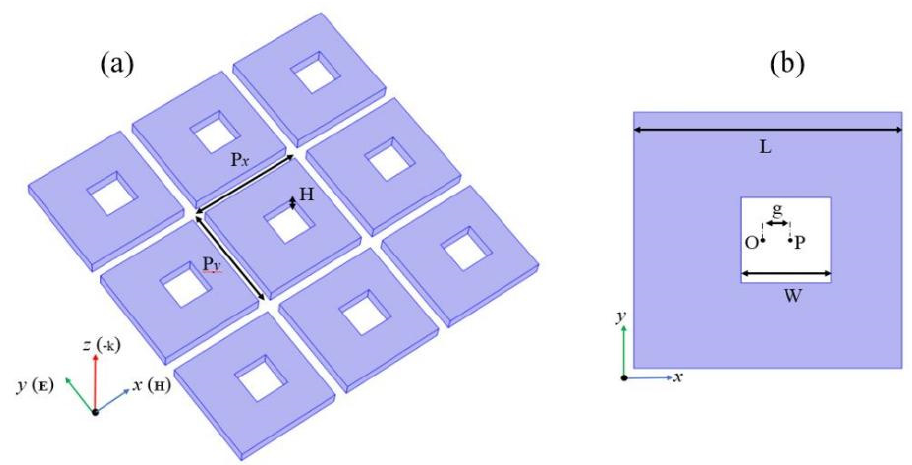
Figure 1. ( a ) Schematic of the SHND nanostructure array and the incident light polarization configuration; ( b ) Top view and geometric parameters of a unit cell of the SHND.